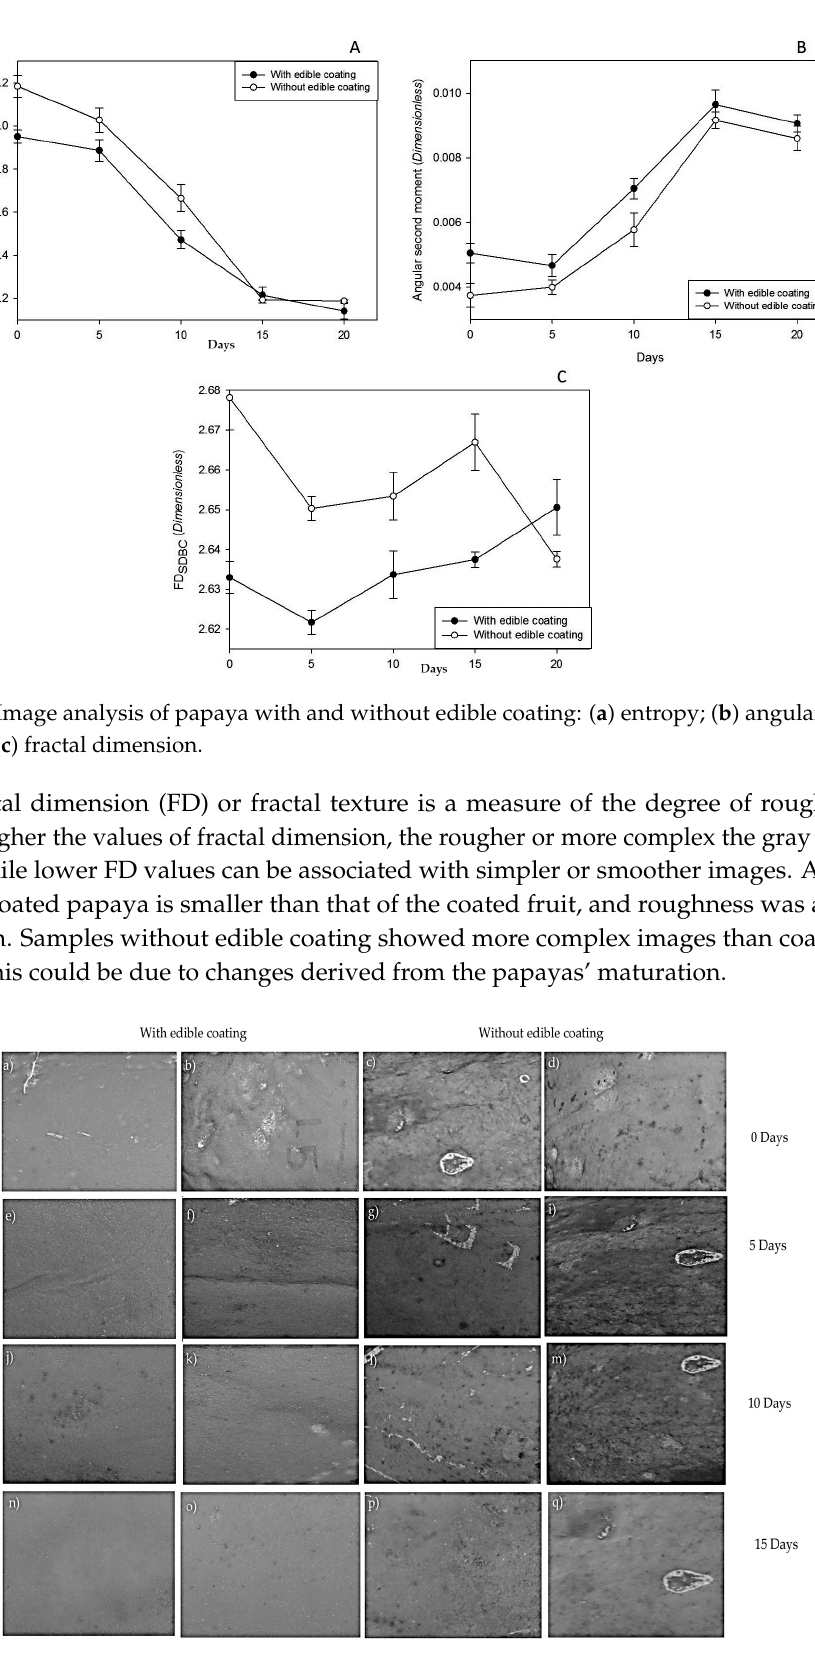
Figure 7. Grayscale papaya crops (8 bits) after different days of storage. 0 days (initial time): with coating ( a , b ); without coating ( c , d ). 5 days: with coating ( e , f ); without coating ( g , i ). 10 days: with coating ( j , k ); without coating ( l , m ). 15 days: with coating ( n , o ); without coating ( p , q ).